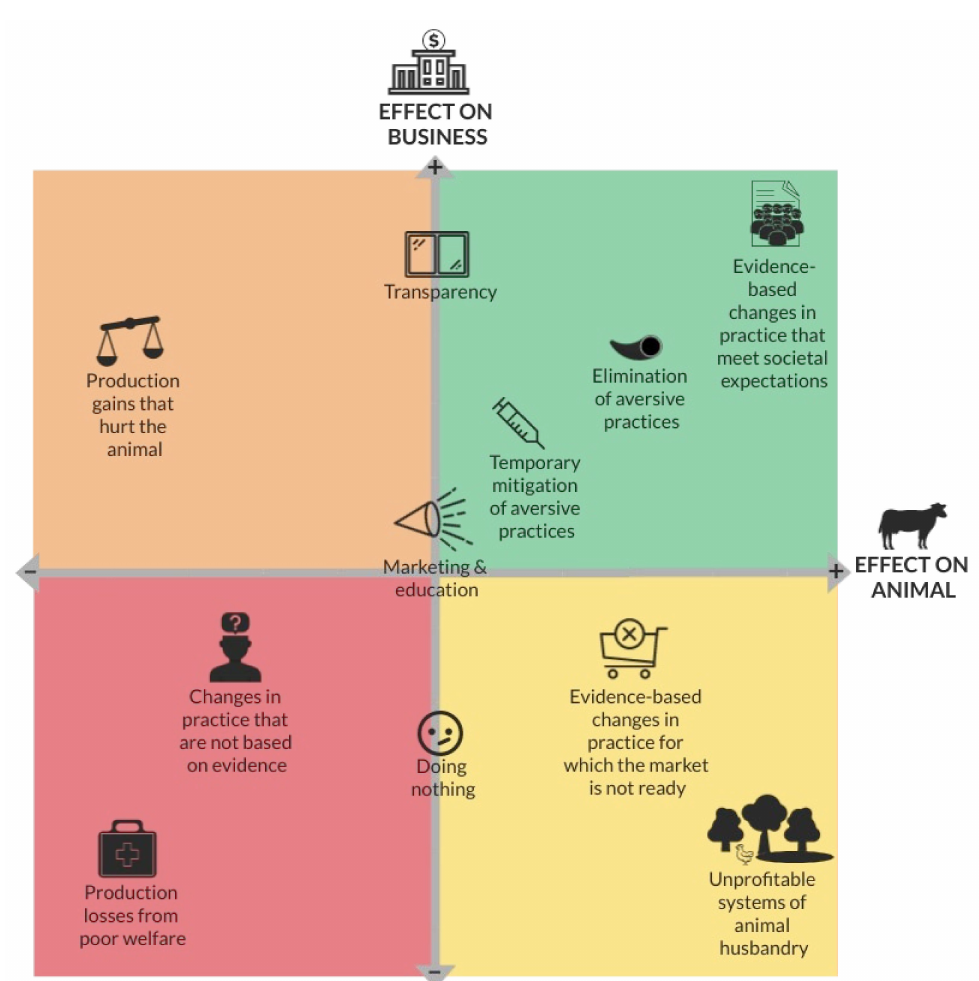
Figure 2. Decision tool for businesses considering changes in practice to improve farm animal welfare. The horizontal axis depicts the effect of the change in practice on the welfare of the animal, with more positive effects towards the right. The vertical axis depicts the effect of the change in practice on the profitability of the business, with more positive effects towards the